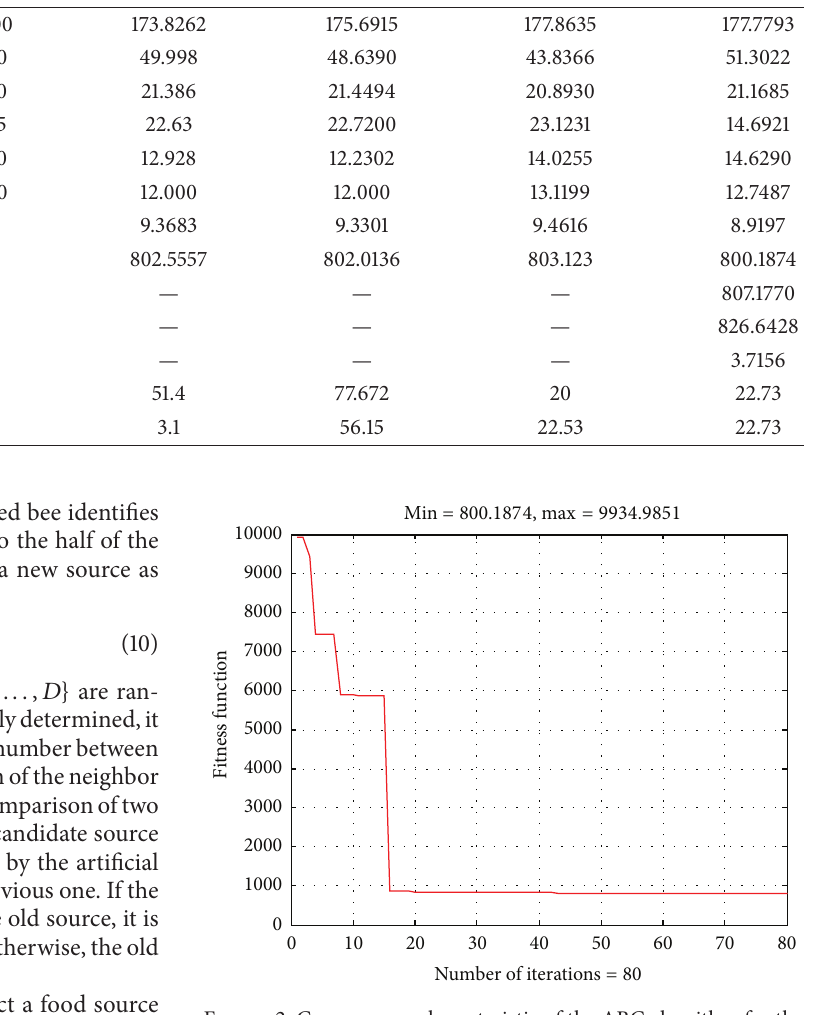
Figure 2: Convergence characteristic of the ABC algorithm for the IEEE 30-bus system with quadratic fuel cost